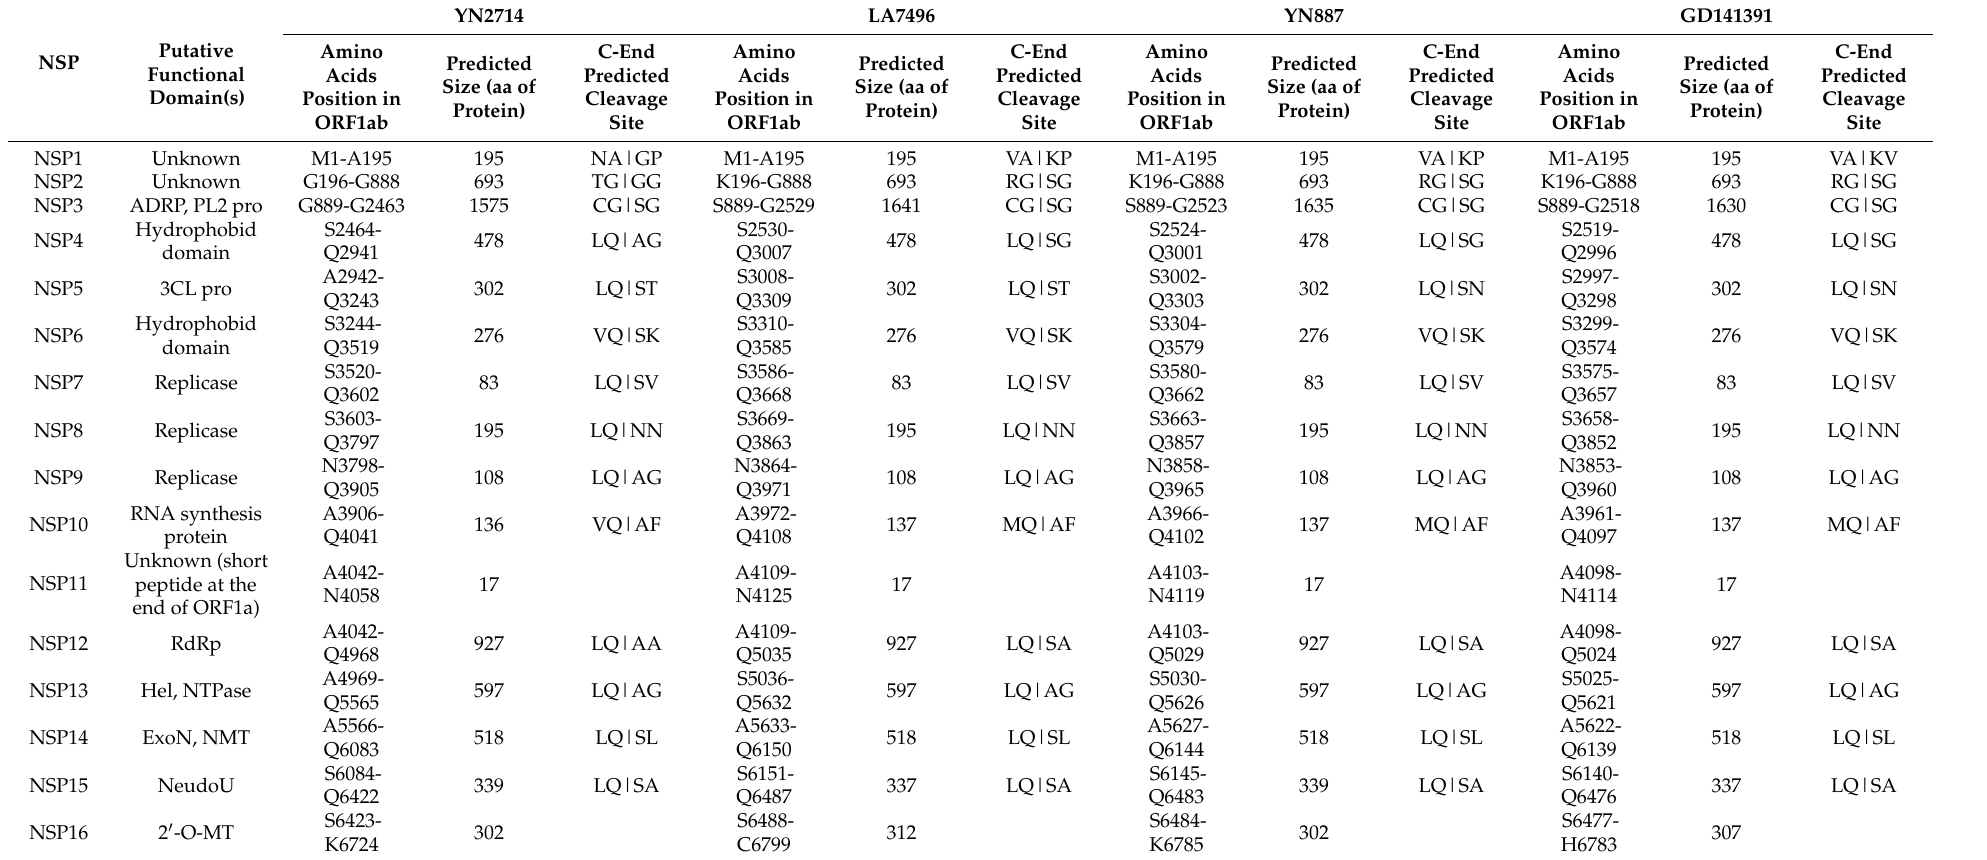
Table 1. Characteristics of predicted nonstructural proteins of ORF1ab in different strains of BtCoV HKU10 in this